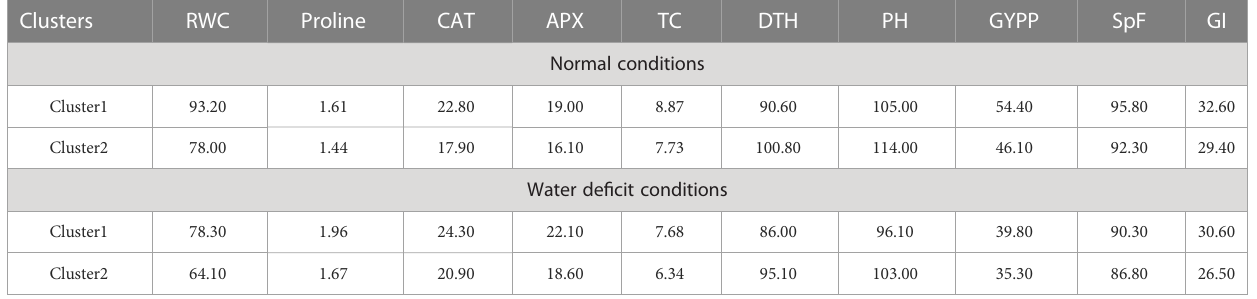
TABLE 8 Averages of the studied traits for the two clusters under normal and water de fi cit conditions.